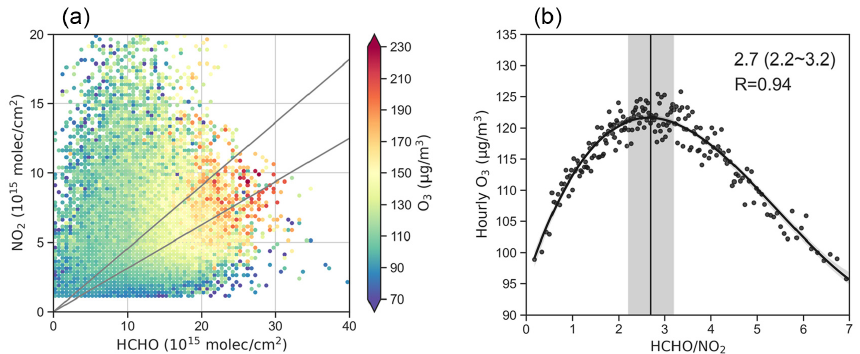
Figure 3. (a) O 3 concentration as a function of TROPOMI HCHO and NO 2 . All surface hourly O 3 observations (13:00 to 14:00 local time) averaged over each half-month from April to September 2019–2021 are aggregated based on the corresponding TROPOMI HCHO and NO 2 (interval: 0.5 unit × 0 . 25 unit). The black lines delineate the TROPOMI HCHO / NO 2 values of 2.2 and 3.2. (b) O 3 concentration (13:00 to 14:00) as a function of TROPOMI HCHO / NO 2 . O 3 average concentration is calculated by first matching hourly O 3 observations with TROPOMI HCHO / NO 2 for each half of the month, dividing these paired observations into 200 bins based on HCHO / NO 2 and then calculating the O 3 average concentration ( y axis) for each TROPOMI HCHO / NO 2 bin ( x axis). The solid line is fitted with third-order polynomial curves, and the shading indicates 95% confidence intervals. The vertical lines indicate the maximum of the fitted curve, and the vertical shading represents the range with the curve slope from − 3 to + 3 (regime transition). Table 1. HCHO / NO 2 threshold values between O 3 production regimes in nine Chinese regions. Region Correlation coefficient a HCHO / NO 2b Transitional regime Beijing–Tianjin–Hebei–Shandong